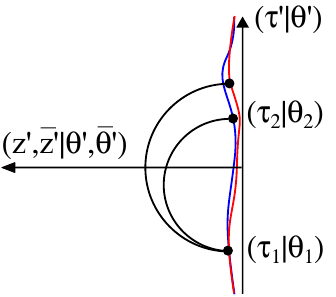
Figure 3 . Geodesics between two boundary endpoints in superspace. The coordinates with primes are Poincaré SUHP coordinates. The coordinates without primes are “proper” or preferred co- ordinates on the boundary superclock. The boundary is 1 | 1 -dimensional, while the bulk is 2 | 2 - dimensional. The bulk geodesics are 1 | 0